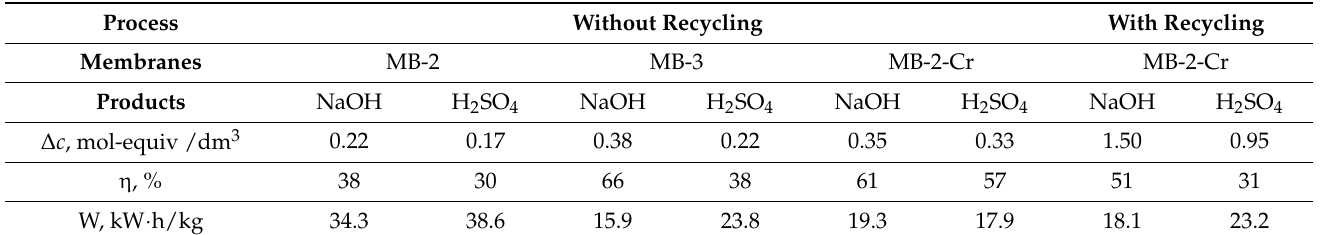
Table 3. Results of experiments on the conversion of sodium sulfate (0.5 mol/dm 3 ) at 64 mA/cm 2 .